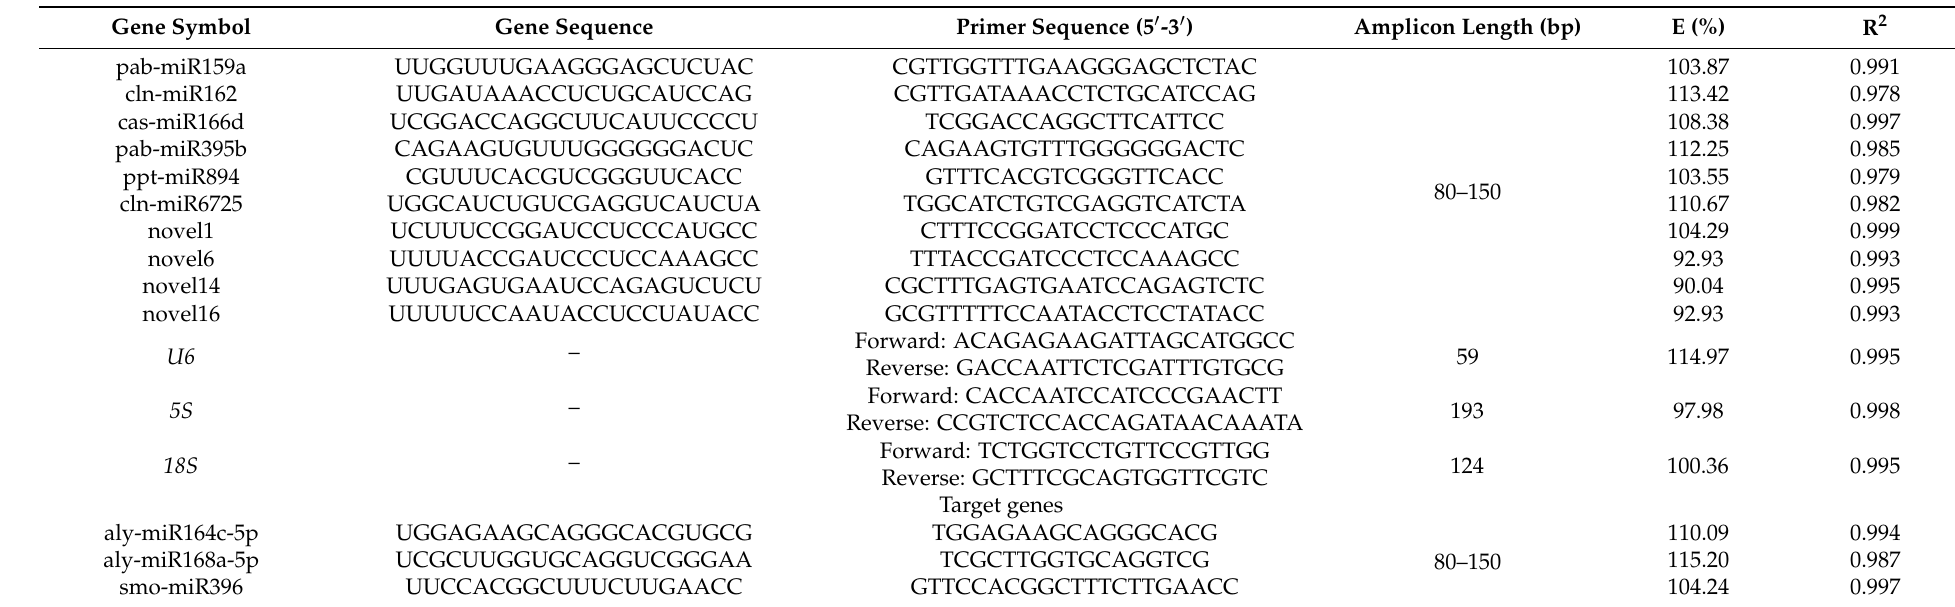
Table 1. Gene sequence and primer